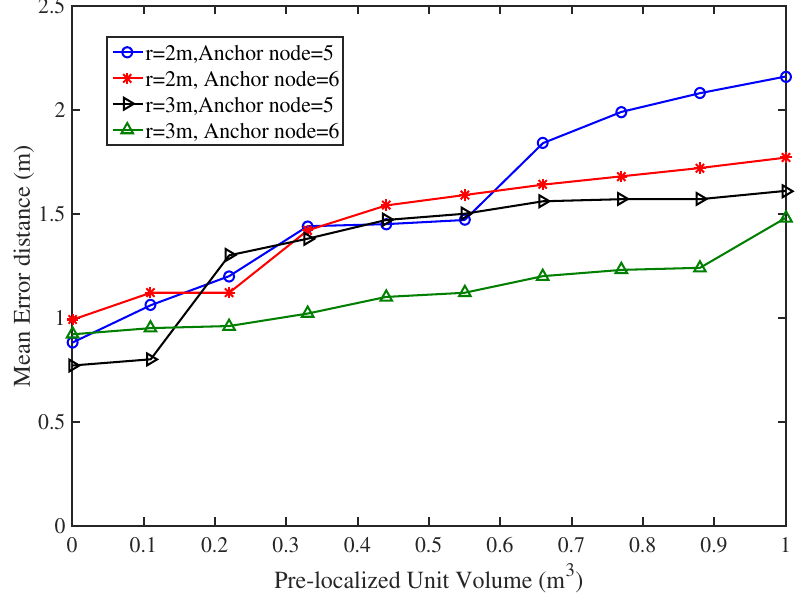
Figure 4. Mean square error of PLD with different localization volumes.